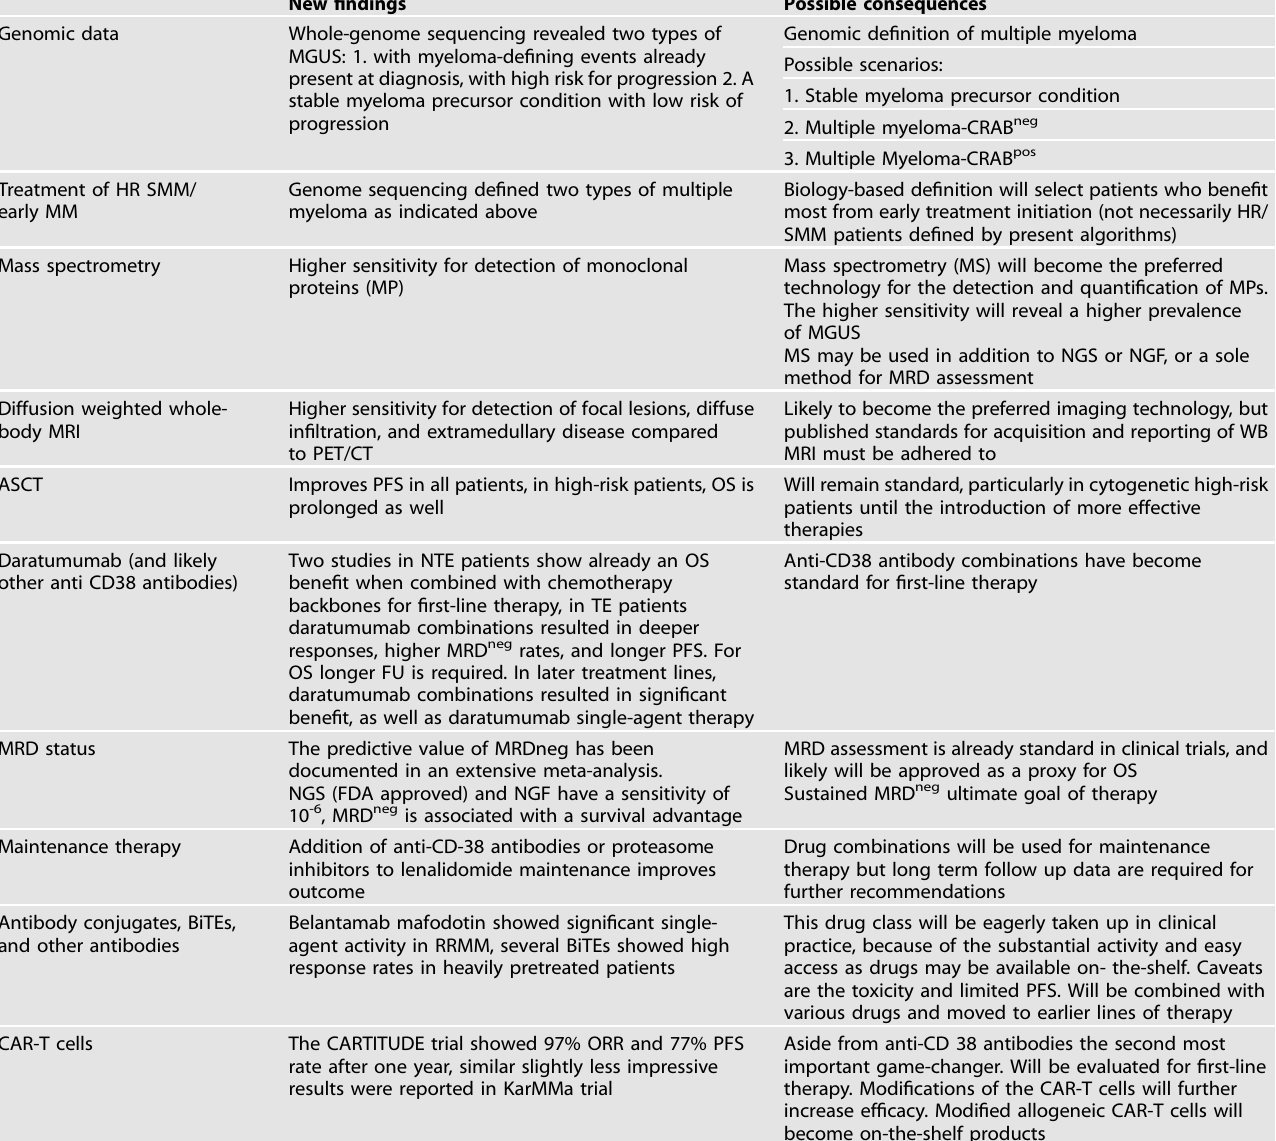
Table 1. Advances in multiple myeloma research with clinical